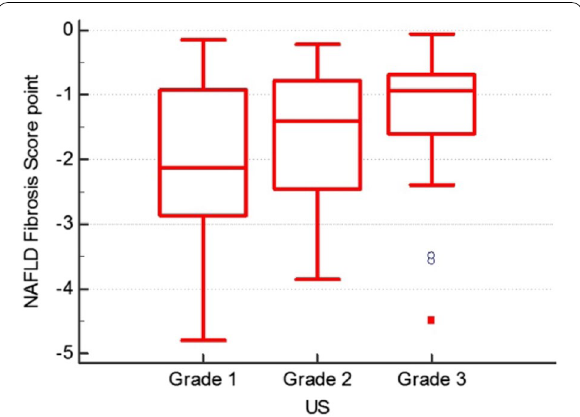
Fig. 2 Box plot showing the median and IQR of NAFLD fibrosis score according to the grade of fatty liver by ultrasound among the patients’